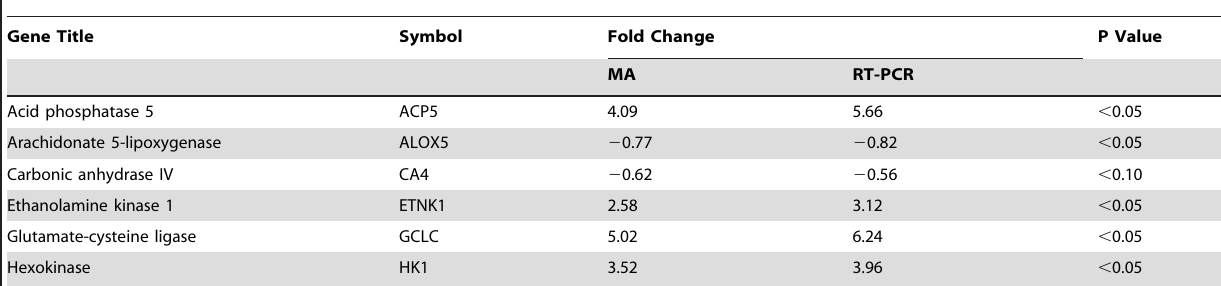
Table 4. Validation of microarray data by